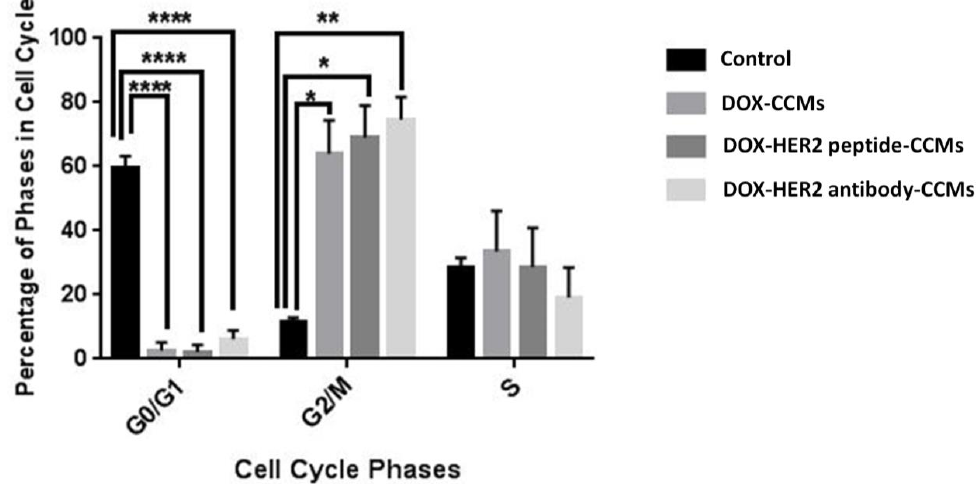
Figure 9. Determination of cytostatic effects of the IC50-loaded DOX-loaded CCMs, DOX-loaded HER2-peptide CCMs, and DOX-loaded HER2-antibody CCMs on the SKBR-3 breast cancer cells after 48 h of incubation. Note that, these experiments were performed in triplicate and repeated three times under similar conditions, and paired t-test was performed for statistical analysis, and p < 0.05:*, p < 0.01:**, and p < 0.0001:**** were considered significant. After cytotoxic, apoptotic and cytostatic assays, the genotoxic effect of DOX-CCMs,